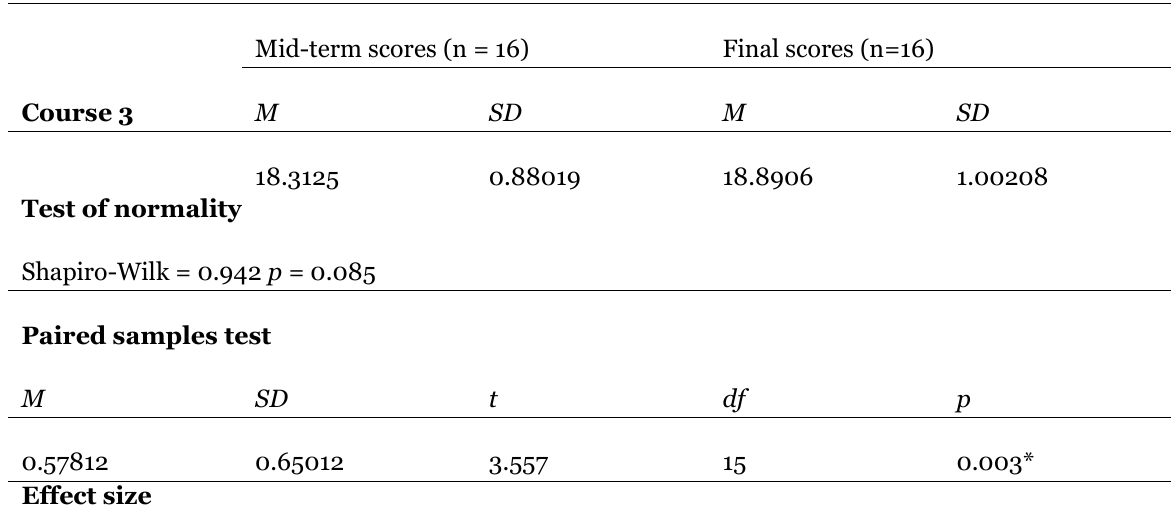
Paired Samples t-Test Results for Preservice Teachers’ Achievements in Online Course